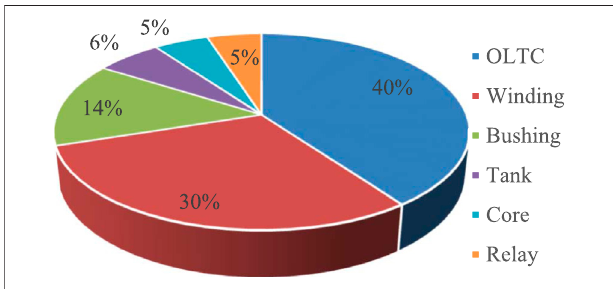
FIGURE 1 | Defective components of a transformer (OLTC: on-load tap